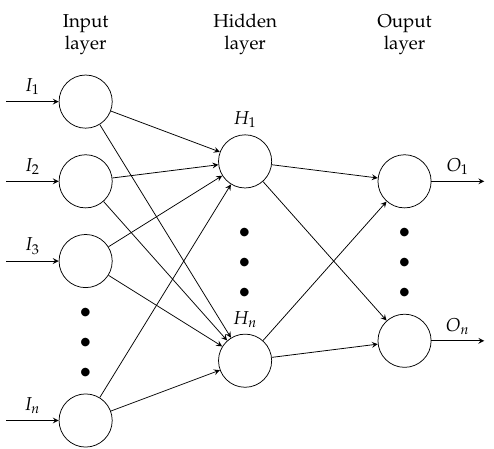
Figure 3. Schematic structure of a feedforward artificial neural